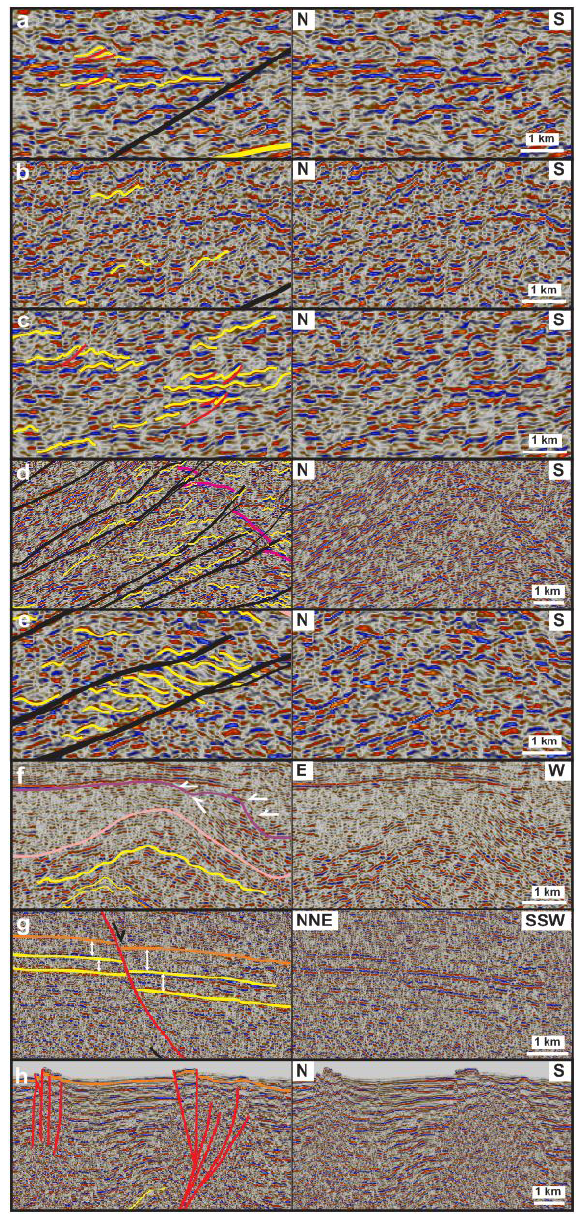
Figure 4. Zoomed-in views of the seismic profiles shown in Fig. 3 showing (a) upright fold structures, (b) SSW-verging folds, and (c) top-SSW minor thrusts in Precambrian–lower Paleozoic (meta)sedimentary basement rocks. (d) SSW-verging folds and NNE-dipping mylonitic shear zones within a major thrust that off- sets major basement unconformities (fuchsia lines) top-SSW. (e) Duplex structures within a major top-SSW thrust and (f) a N–S- to NNE–SSW-trending, 5–15km wide, symmetrical, upright macro- fold with an associated scale of kilometers to hundreds of me- ters and parasitic macro- to meso-folds. (g) Syn-tectonic thicken- ing in Devonian–Carboniferous (–Permian?) sedimentary strata off- set down-NNE by a normal fault that merges with a thick my- lonitic shear zone at depth. (h) Recent–ongoing reverse offsets of the seafloor reflection by multiple inverted, NNE-dipping normal faults in Storfjorden. See Fig. 3 for the location of each zoom and for the